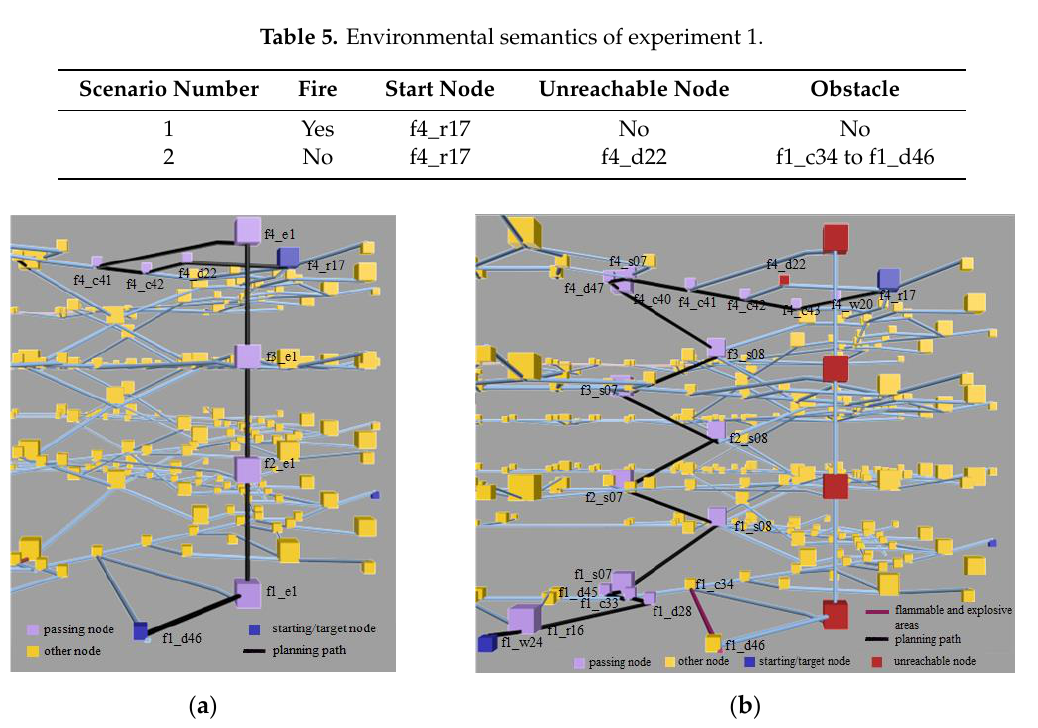
Figure 9. Impact of path accessibility on indoor pathfinding. ( a ) Planning path in scenario 1; ( b ) Planning path in scenario 2.